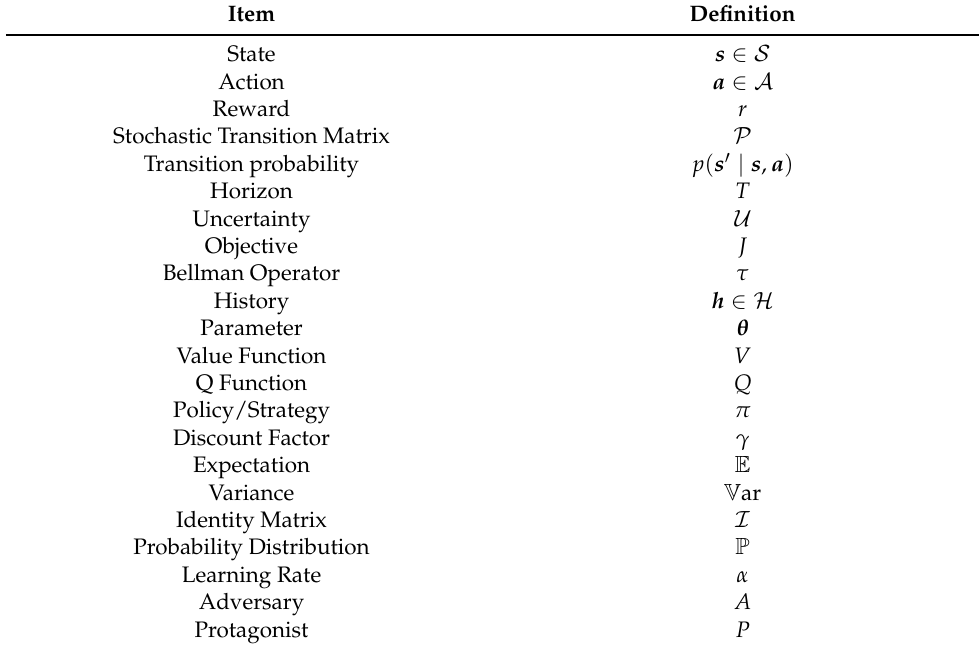
Table 1. A list of the most important notations used in this